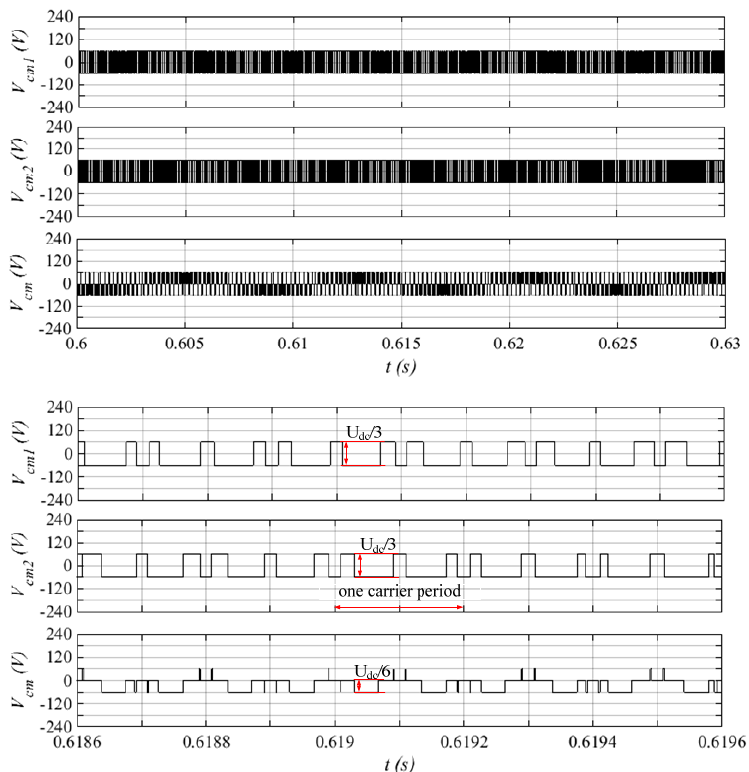
Figure 8. Simulation results of CMV for the proposed DZICMV strategy: two sub-CMVs V cm1 and V cm2 , total CMV V cm .